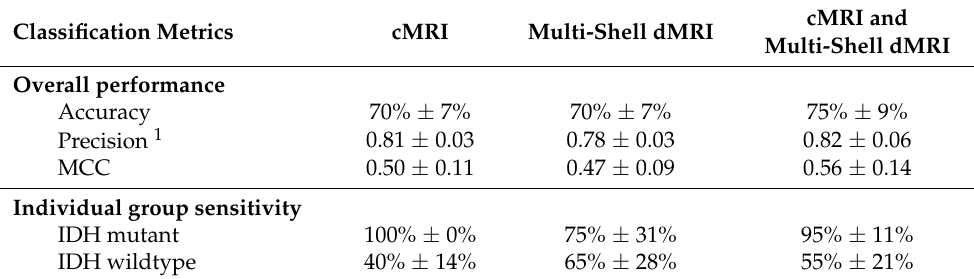
Table 3. IDH status classification performance in LGGs (WHO 2016).